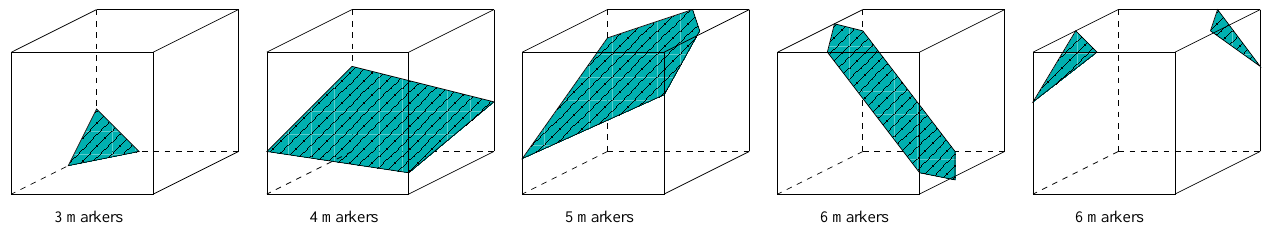
Fig. 1. Possible configurations for cut cell intersection. The last two cases are excluded.